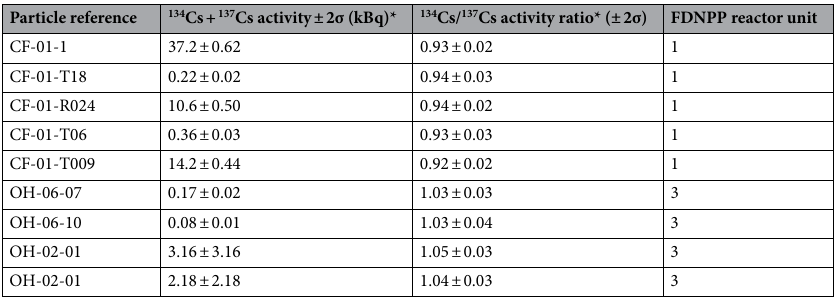
Table 1. Summary of 134 Cs/ 137 Cs activity ratios (derived by gamma-ray spectroscopy) and the associated measurement uncertainties (2σ) for the representative particulates studied in this work, alongside the attributed FDNPP reactor Unit. *Decay corrected to March